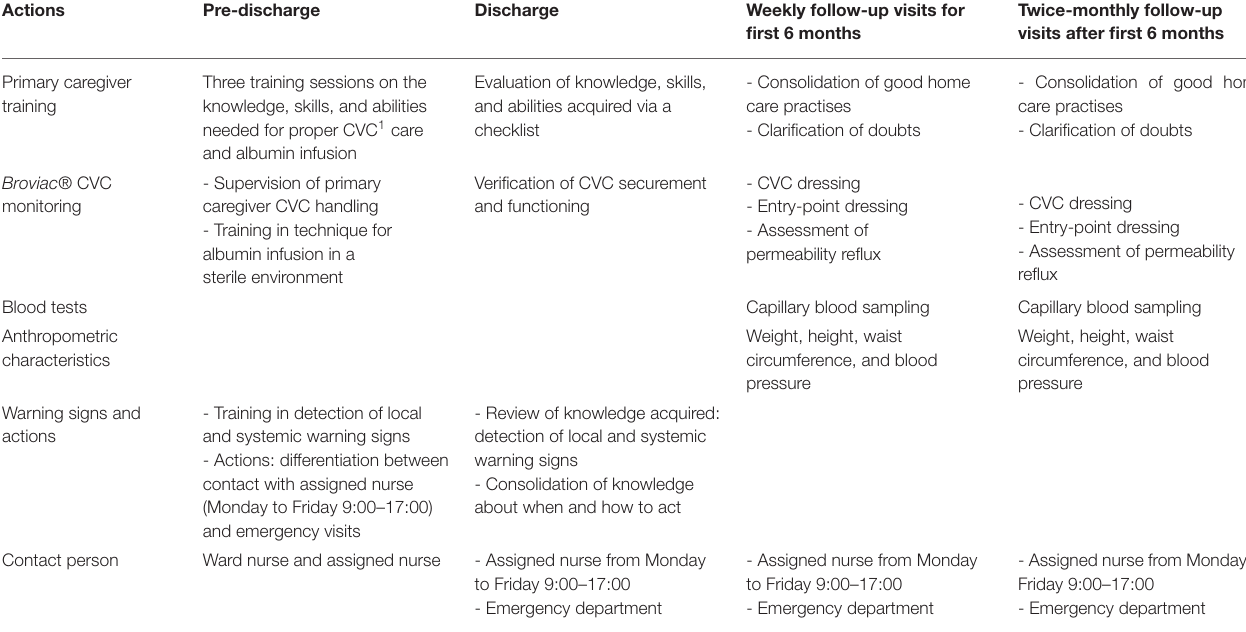
TABLE 1 | Interventions by the nursing in the home albumin infusion therapy program.